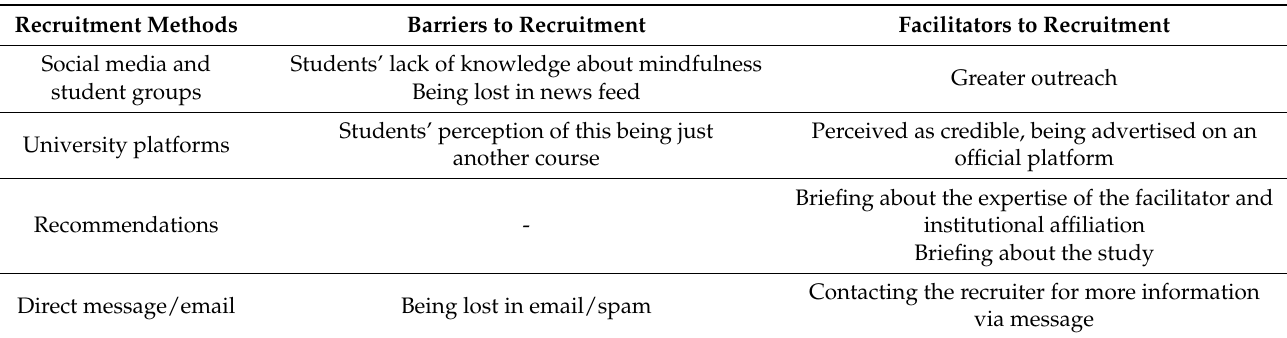
Table 2. Barriers and Facilitators to recruitment